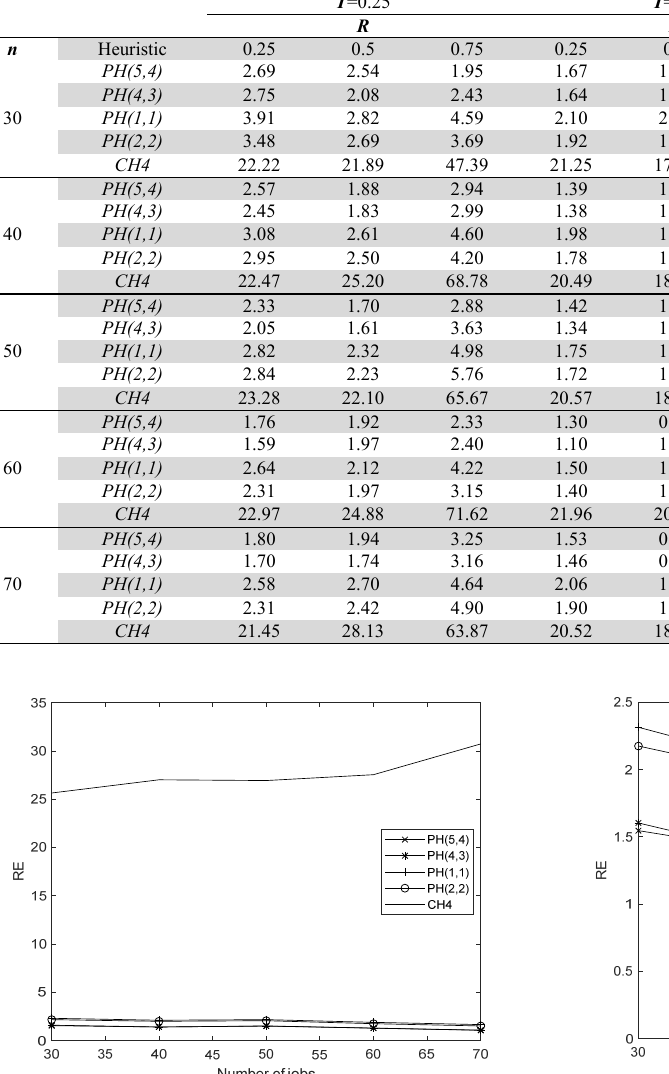
Fig. 6. Heuristic comparisions with respect to number of jobs